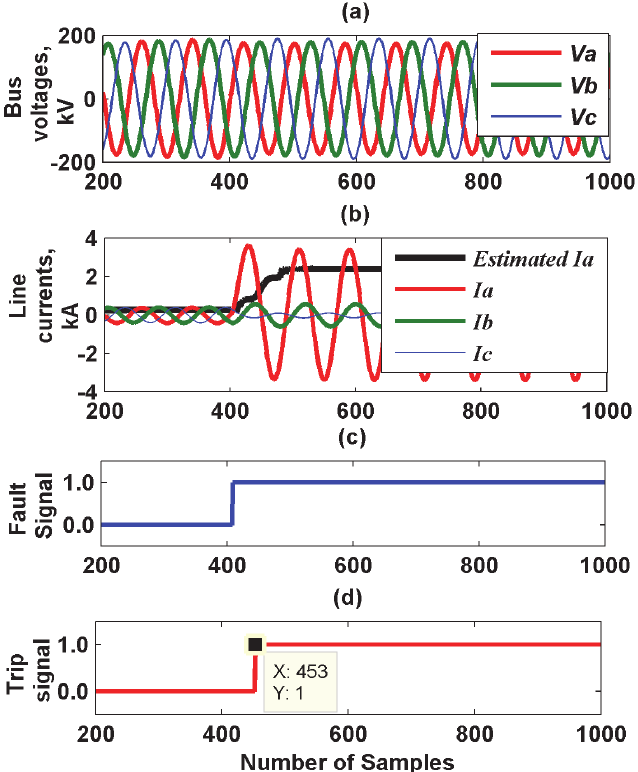
Fig. 10. (a) Bus voltages, (b) line currents and estimated value of fault current (c) Fault Signal and (d) Trip Signal during L-G fault applied at 50 km at 0.1 s with R F = 20 Ω and FIA =